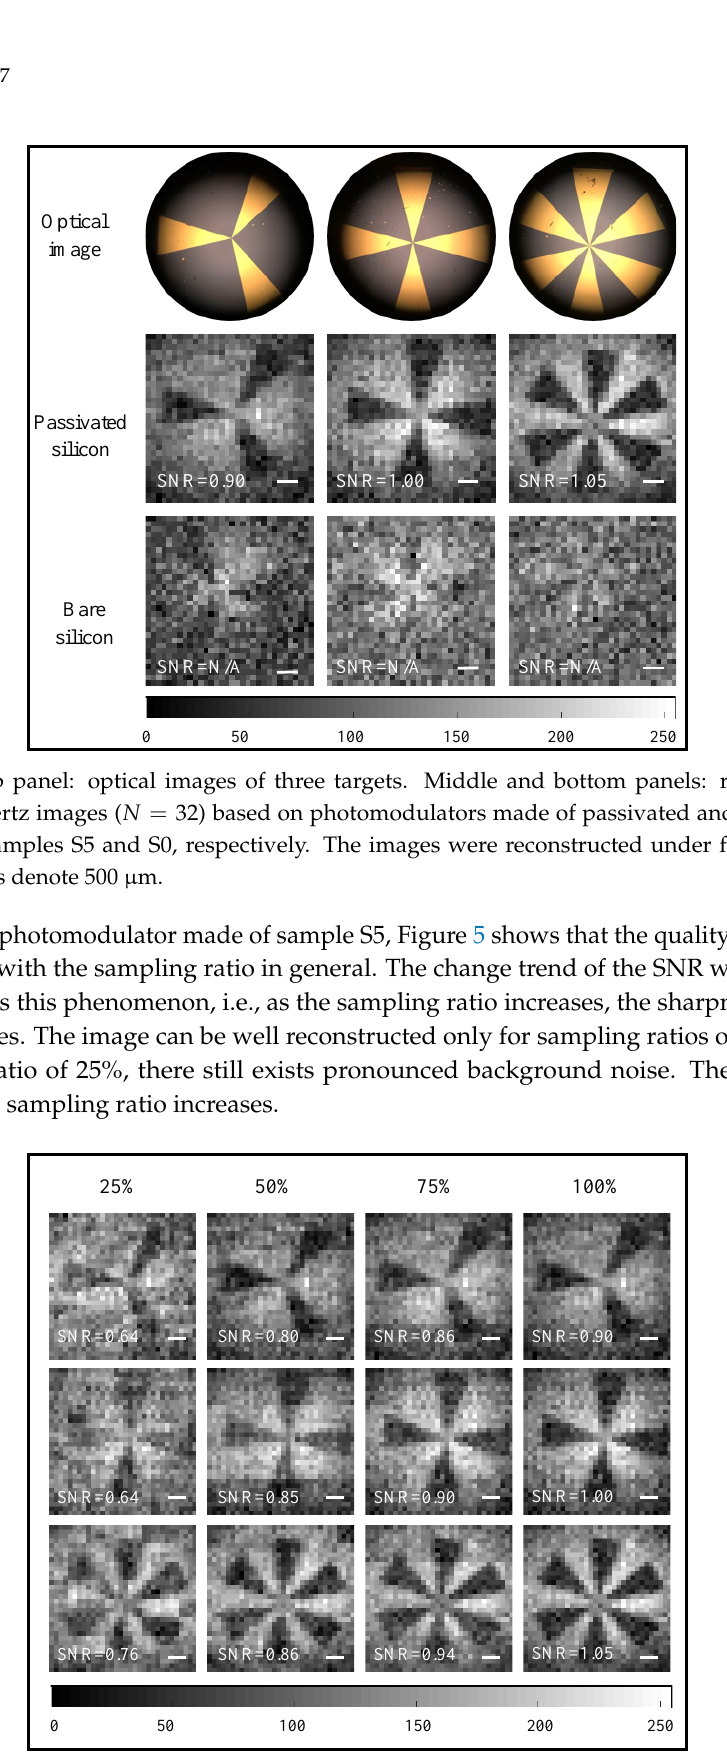
Figure 5. Reconstructed 32 × 32 terahertz images under different sampling ratios: 25%, 50%, 75% and 100%. Scalar bars denote 500 µ